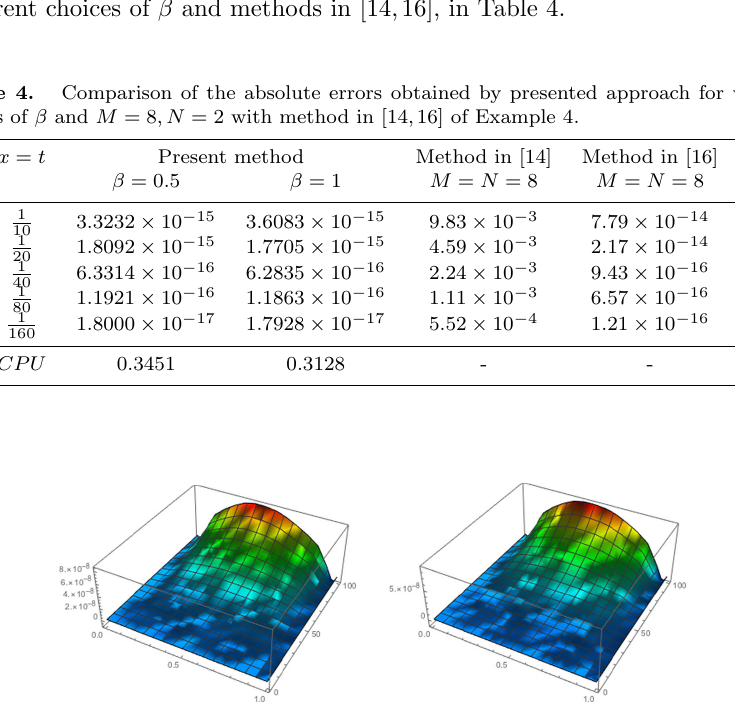
Figure 3. The absolute error for ν = 1 . 75 (left) and ν = 1 . 95 (right) with M = 8 ,N = 2 and β = 1 on the interval [0 , 1] × [0 , 100] of Example